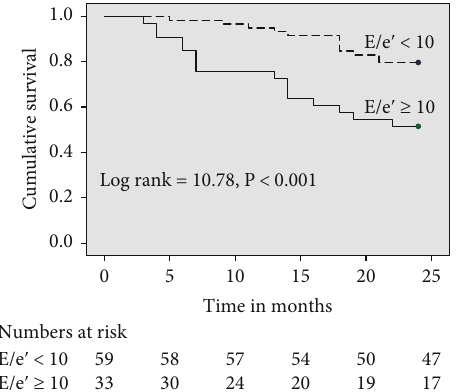
Figure 1: Kaplan-Meier survival curve of decompensated cirrhosis patients according to E / e ′ values. Those patients having E / e ′ ≥ 10 had lower survival rate than patients than E / e ′ < 10 ( p = 0 : 001